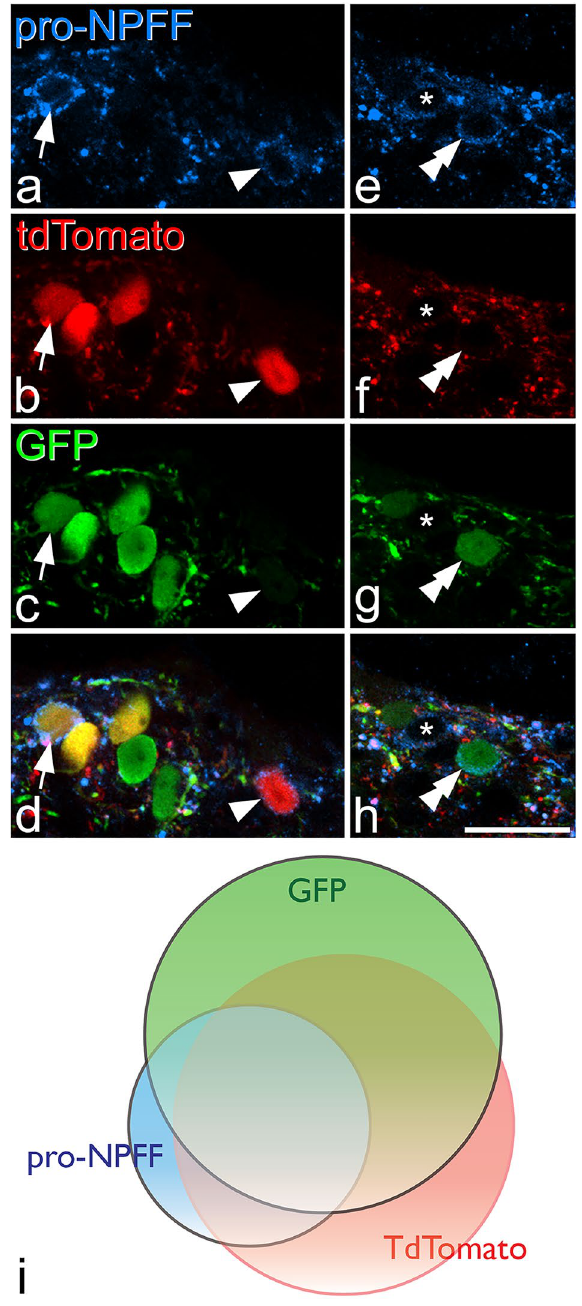
Figure 3. The relation of pro-NPFF immunoreactivity to expression of tdTomato and GFP in a NPFF Cre mouse following intraspinal injection of AAV.flex.GFP. ( a )–( d ): show part of the section illustrated in Fig. 2 scanned to reveal immunostaining for pro-NPFF (blue) as well as expression of tdTomato (red) and GFP (green). Two pro-NPFF-positive cells can be identified by the presence of immunoreactivity in the perikaryal cytoplasm, which surrounds the unstained nucleus. One of these cells (arrow) contains both fluorescent proteins, while the other (arrowhead) contains tdTomato but lacks GFP. ( e )–( h ): a nearby field from the same section. Again, this contains two pro-NPFF-positive cells, but in this case one is GFP + /tdTomato-negative (double arrowhead), and the other (asterisk) lacks both fluorescent proteins. Among pro-NPFF-immunoreactive cells, 67% were labelled with both GFP and tdTomato, 7.7% only with GFP, 13.5% only with tdTomato, while 11.9% did not contain either fluorescent protein. All images are projections of 2 optical sections at 1 μm z-separation. ( i ): Venn diagram showing the extent of overlap of cells labelled with GFP (green), tdTomato (pink) or pro-NPFF- immunoreactivity (blue). Scale bar for ( a )–( h ) = 10